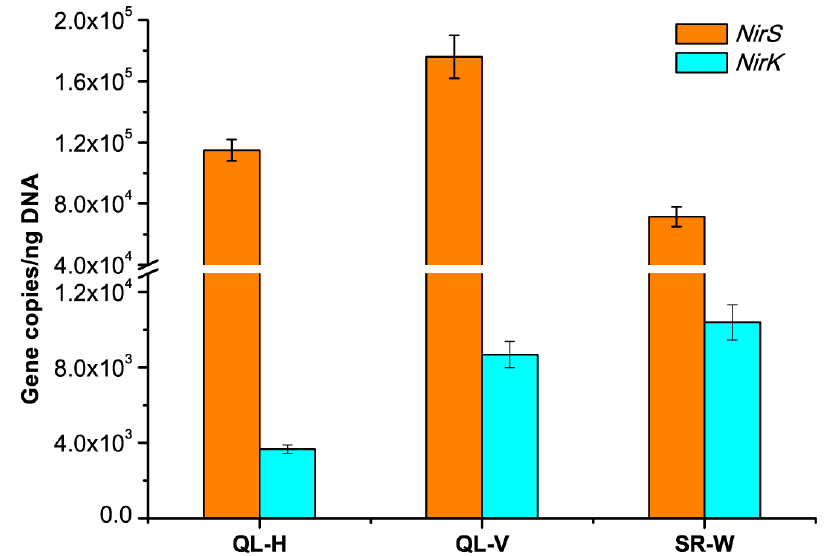
Figure 5. PCR measurements for NirS and NirK gene copy numbers expressed per nanogram of total DNA. Mean values and standard deviations were calculated according to the triplicate assay within a single qPCR setup.